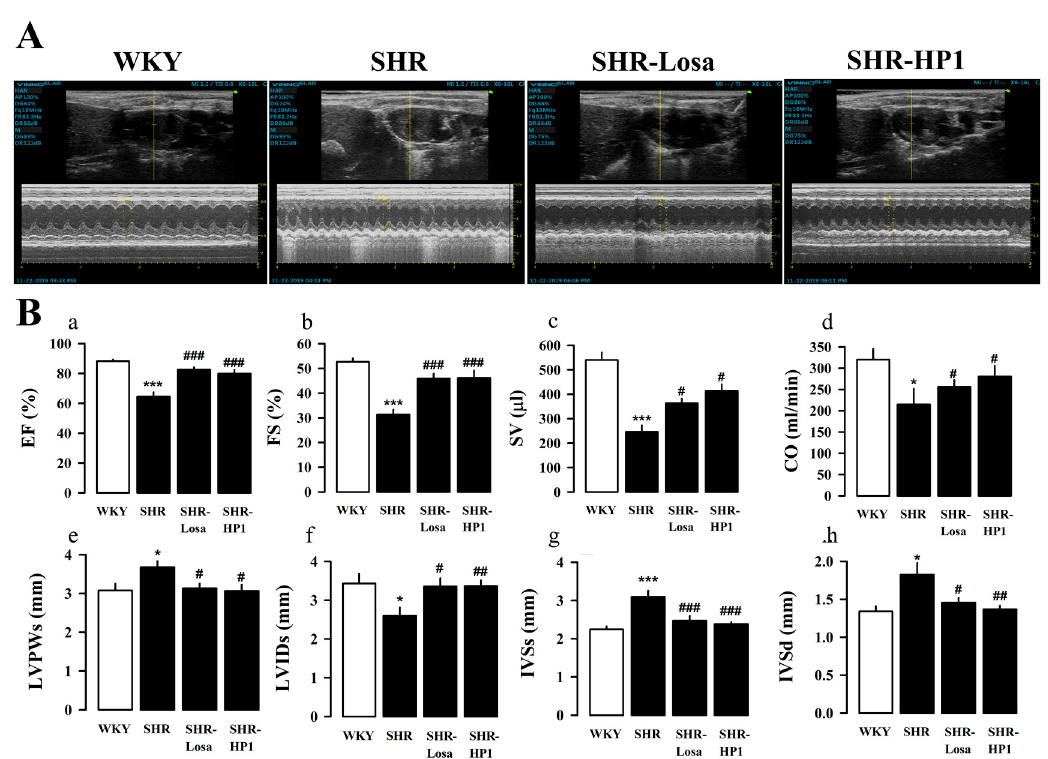
Figure 3. Effect of HP1 on left ventricle (LV) remodeling in SHRs. Representative echocardiography images (M-mode) for each group ( A ). Changes of ejection fraction (EF), fractional shortening (FS), stroke volume (SV), cardiac output (CO), left ventricular posterior wall thickness at end-systole (LVPWs), left ventricular internal dimension at end-systole (LVIDs), interventricular septal thickness at end-systole (IVSs), and interventricular septal thickness at end-diastole (IVSd) were measured echocardiography in each group ( Ba – h ). WKY, Wistar-Kyoto rat; SHR, spontaneously hypertensive rat; Losa, losartan; and HP1, Vitis labrusca leaves extract. Open bar, WKY; closed bar, SHRs. Data are shown as means ± standard error ( n = 10~12 for each group). * p < 0.05 and *** p < 0.001, compared with the WKY group; # p < 0.05, ## p < 0.01, and ### p < 0.001 compared with the SHR group.